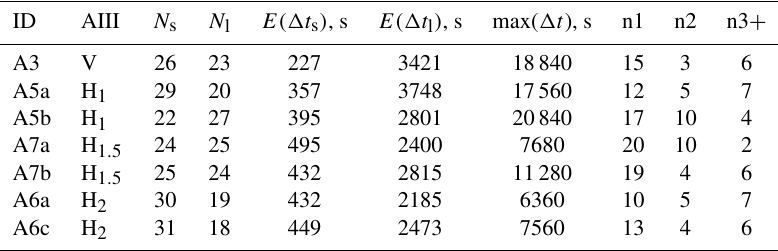
Table 2. Peak-to-peak interevent time statistics: ID identifies the 24h heating experiment; AIII indicates position of the 2m bar: V for vertical and H z for horizontal at height z ; N s is the number of short ( (cid:49)t < 12min) intervals; N l is the number of long ( (cid:49)t > 12min) intervals; E((cid:49)t s ) is the average duration of the short intervals, in s; E((cid:49)t l ) is the average duration of the long intervals, in s; columns n1, n2, and n3 + give the number of single, double, and multiple pulses,